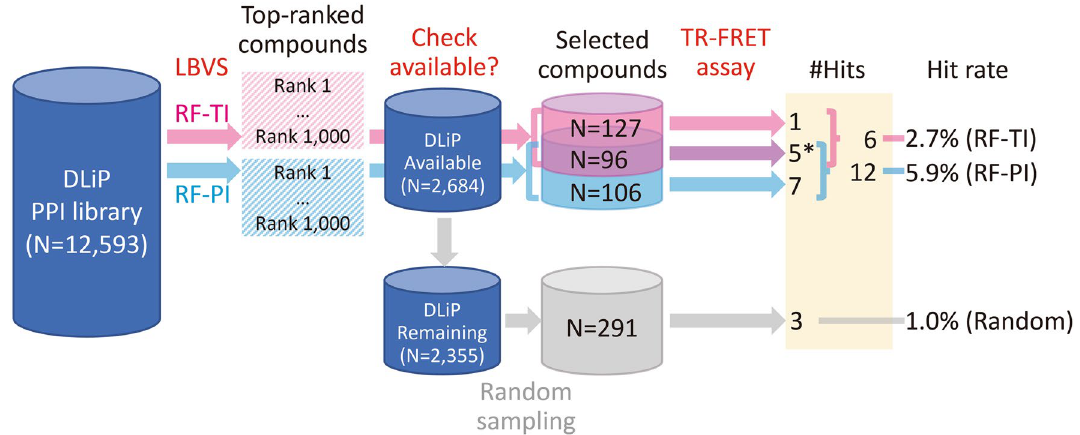
Figure 3. A diagram of the flow from compound selections to TR-FRET assay results. The number of hit compounds marked by asterisk includes a non-specific